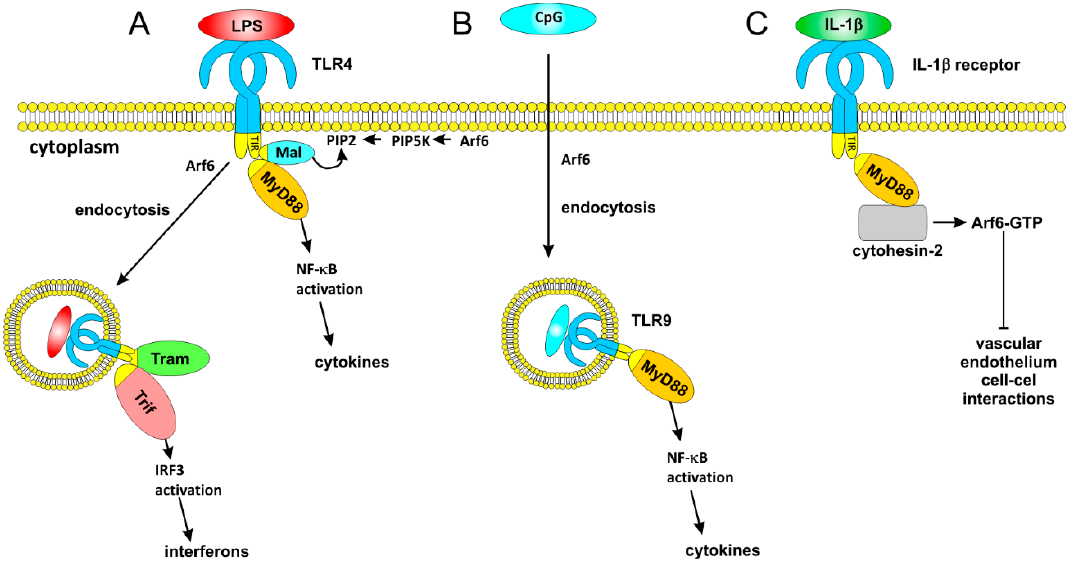
Figure 6. The role of Arf6 in TLR signal transduction. ( A ) TLR4 requires Arf6 for its